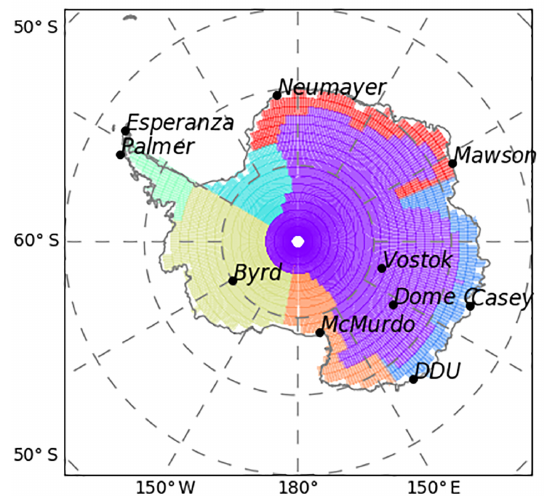
Figure 1. Spatial distribution of Antarctica in seven regions: East Antarctic Plateau, coastal Indian, Weddell sea, West Antarctic Ice Sheet, Victoria Land, and Dronning Maud Land. The location of the selected READER surface stations: Neumayer, Mawson, Vostok, Dome C, Casey, Dumont d’Urville (noted as “DDU”), McMurdo, Byrd, Palmer, and